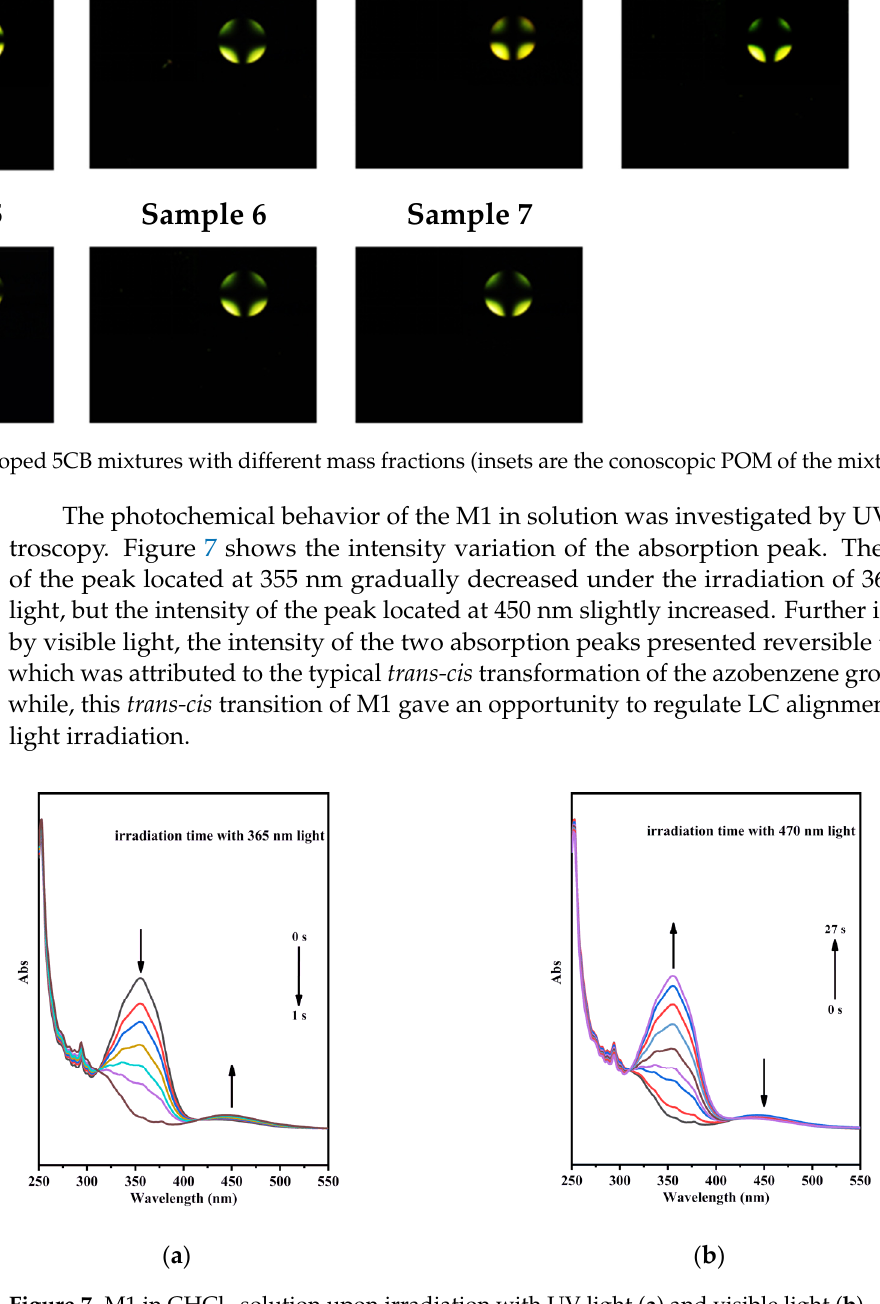
Figure 7. M1 in CHCl 3 solution upon irradiation with UV light ( a ) and visible light ( b ).